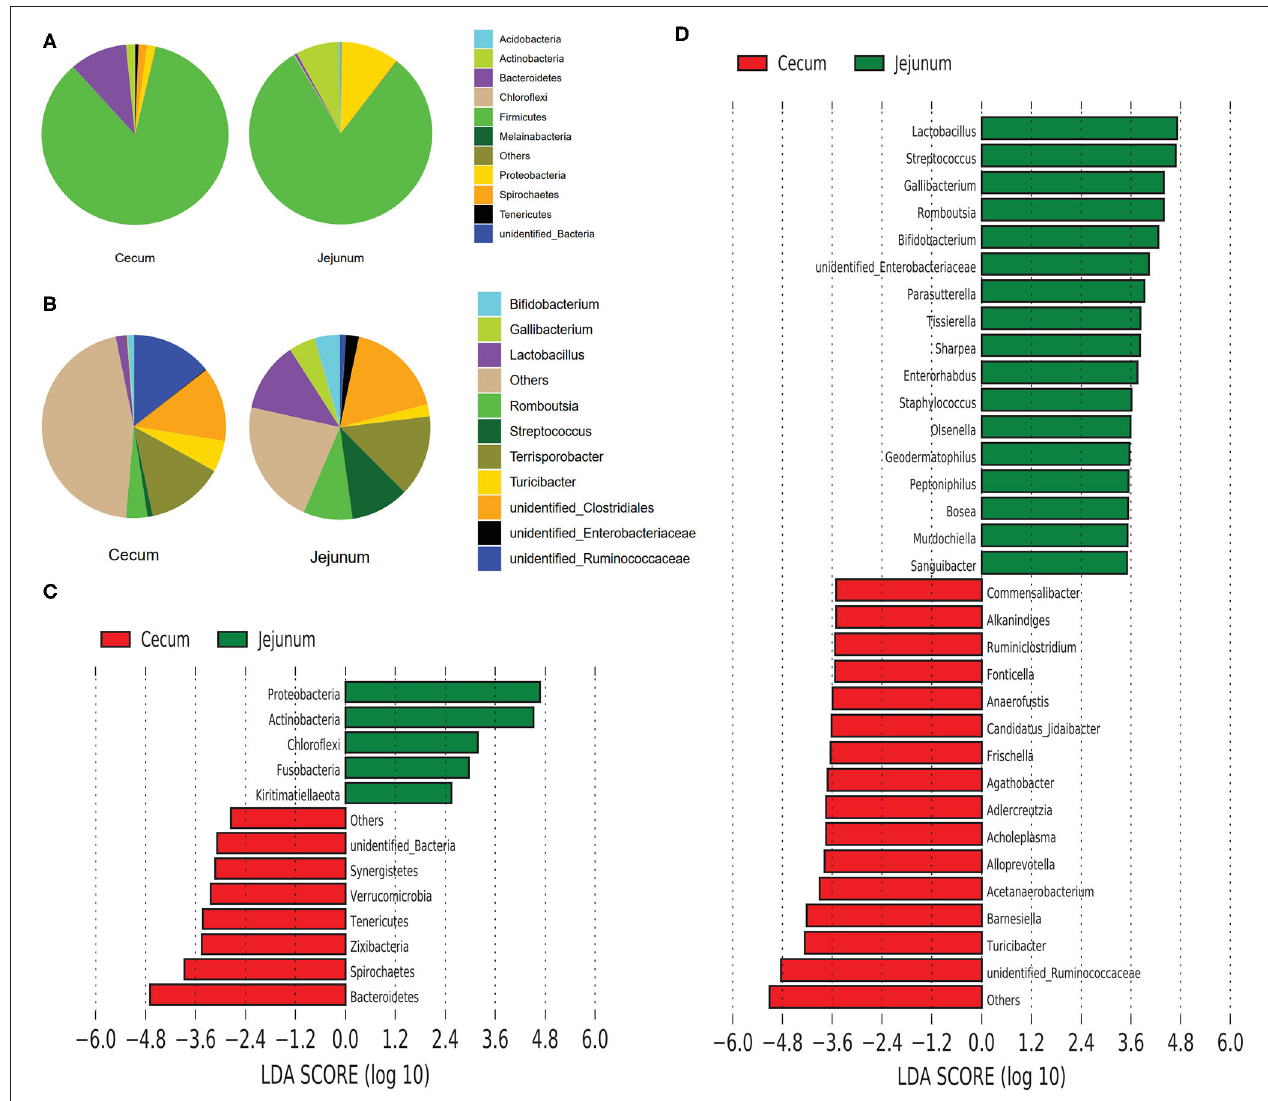
FIGURE 2 | Composition analysis of bacteria from the two gut segments. (A) Microbial composition at the phylum (A) and genus (B) level. LEfSe identified significantly different bacteria according to the relative abundance between the two gut segments at the phylum level (C) and genus level (D) ( p < 0.05, LDA Score > ± 2.0 at the phylum level, and LDA Score > ± 3.5 at the genus level). group in the cecum (Wilcoxon test, p < 0.05; Figures 3A,B